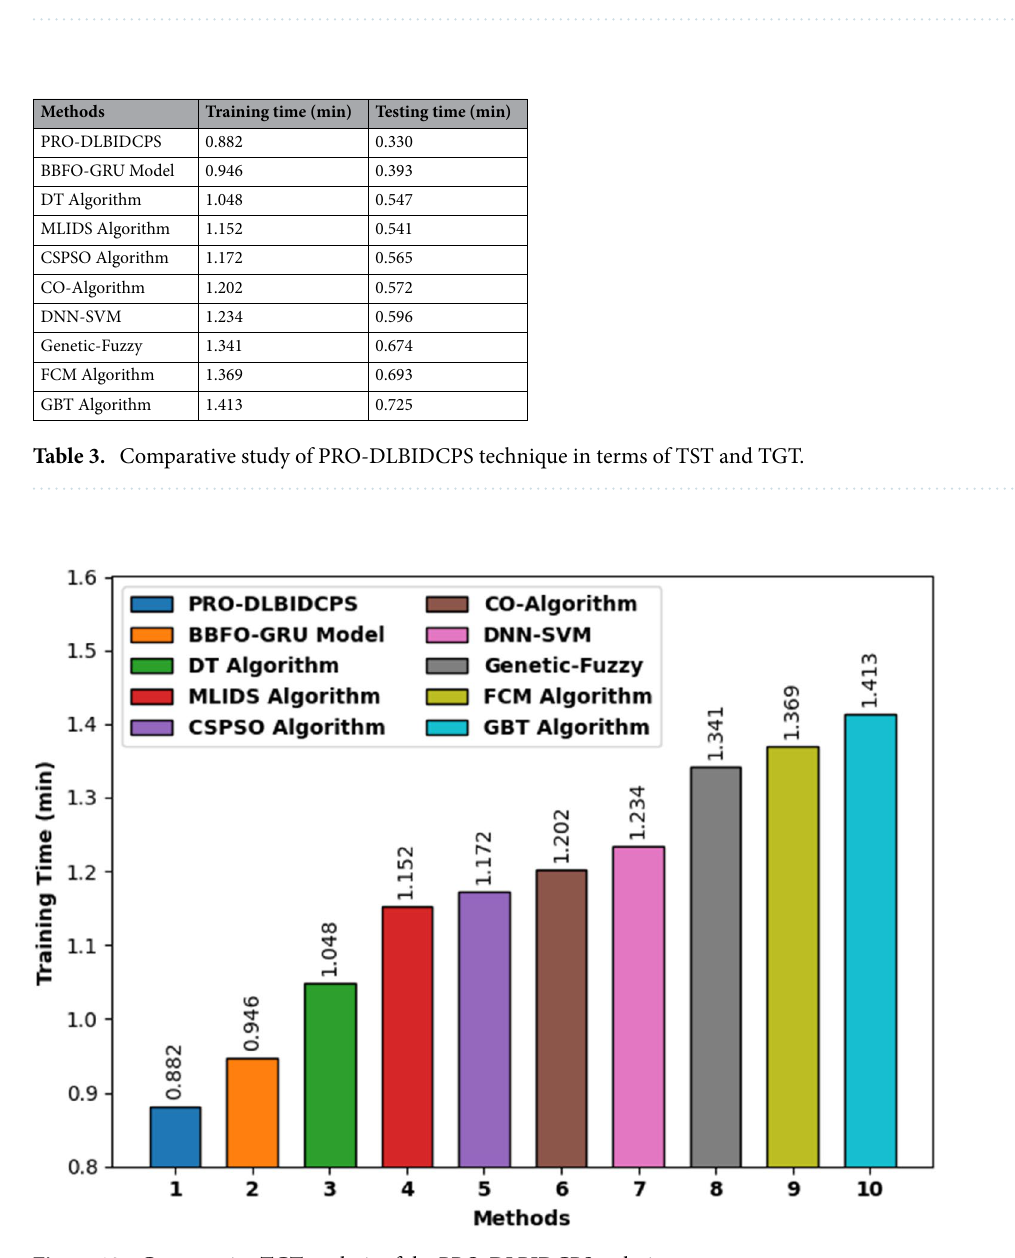
Figure 13. Comparative TGT analysis of the PRO-DLBIDCPS